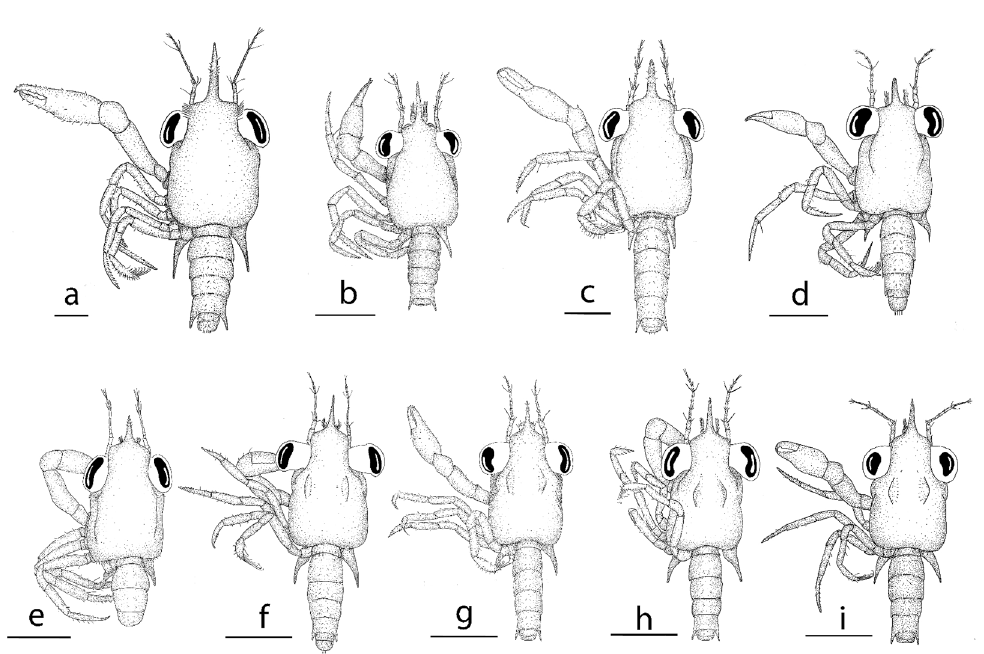
Figure 2. Dorsal view of megalopa: ( a ) Achelous floridanus ; ( b ) Arenaeus mexicanus ; ( c ) Portunus hastatus ; ( d ) Charybdis (Charybdis) hellerii ; ( e ) Thalamita admete ; ( f ) Callinectes toxotes ; ( g ) Callinectes arcuatus; ( h ) Callinectes ornatus; ( i ) Callinectes amnicola . Scale bars: 1